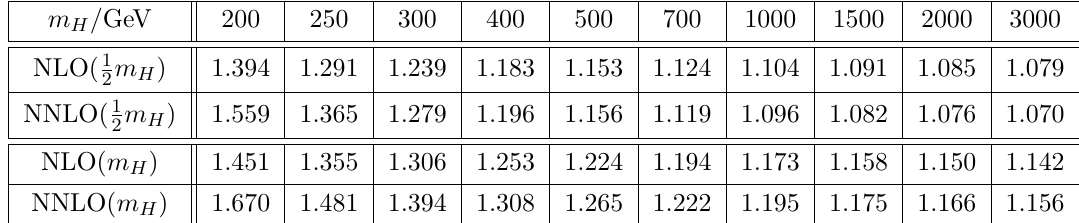
Table 1. Ratios Γ (N)NLO ( µ R ) / Γ LO ( µ R ) for µ R = m H / 2 or m H . Monte-Carlo statistical uncertain- ties at NNLO are small and not